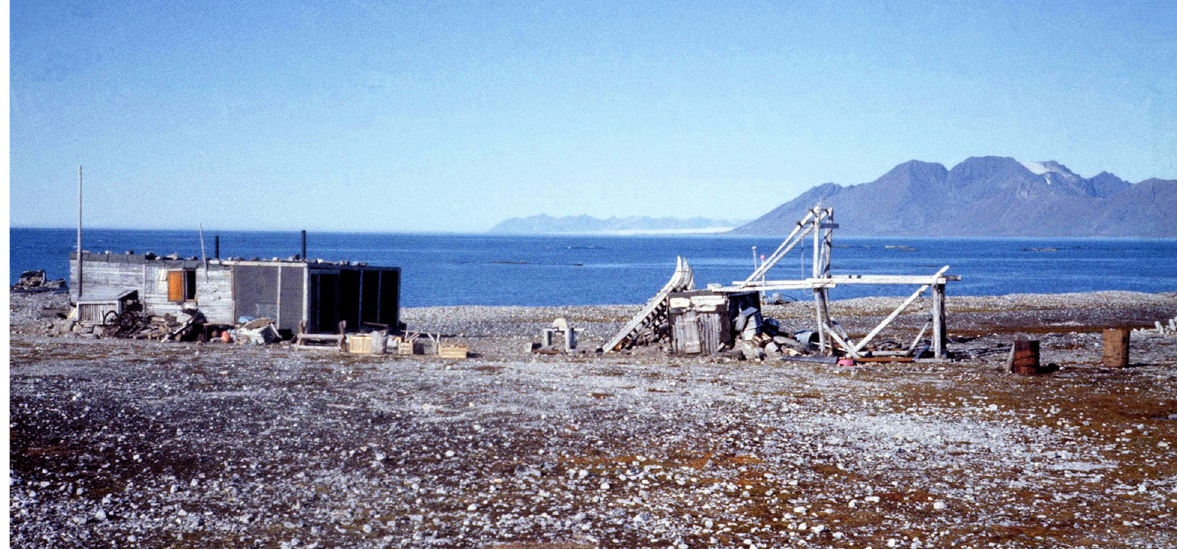
Fig. 2. Norwegian trapper station from the 20 th century near Palffyodden, Sør-Spitsbergen National Park, active until establishing the park in 1973 (Photo: W.Ziaja